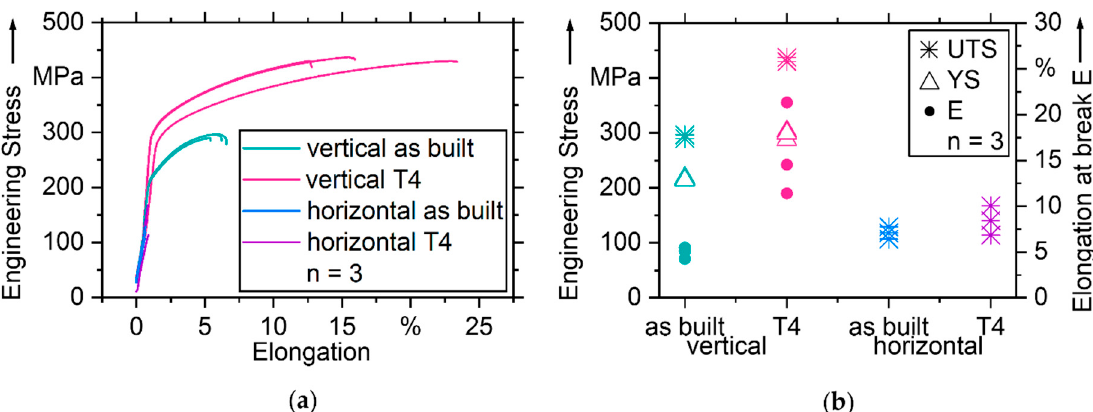
Figure 15. Tensile test results; ( a ) stress-strain curves; ( b ) characteristic values Ultimate Tensile Strength (UTS), Yield Strength (YS) and Elongation at break (E).